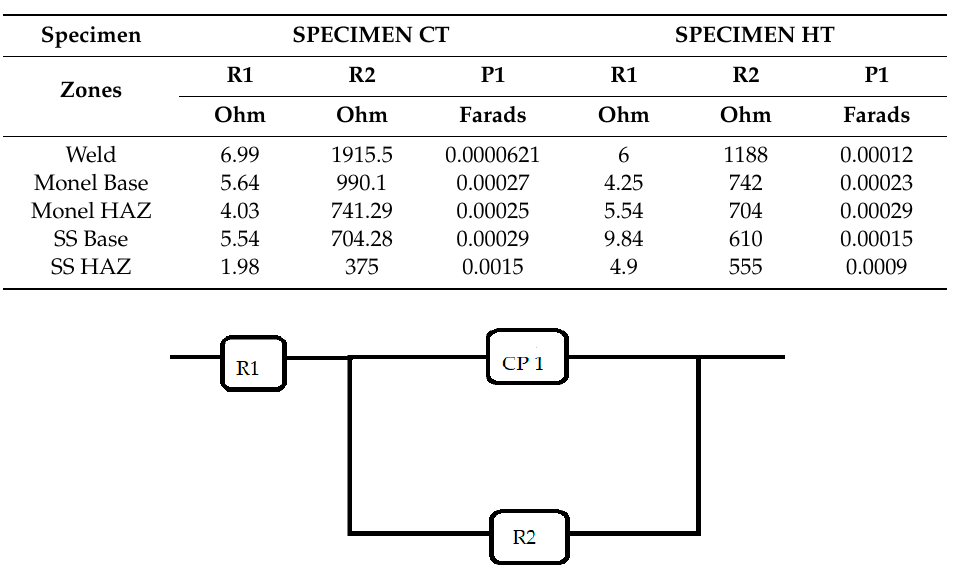
Table 4. Summary of resistance and capacitance of equivalent circuit.